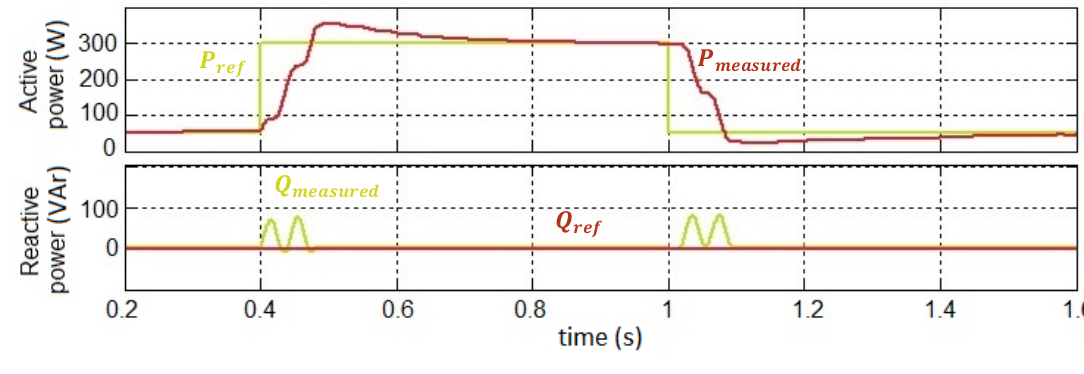
Figure 18. Active and reactive powers diagram.